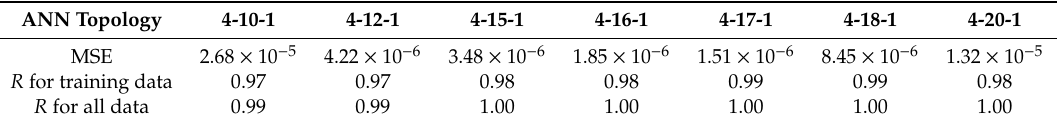
Table 6. Results of ANNs training: MSE and R values for the training data and for all